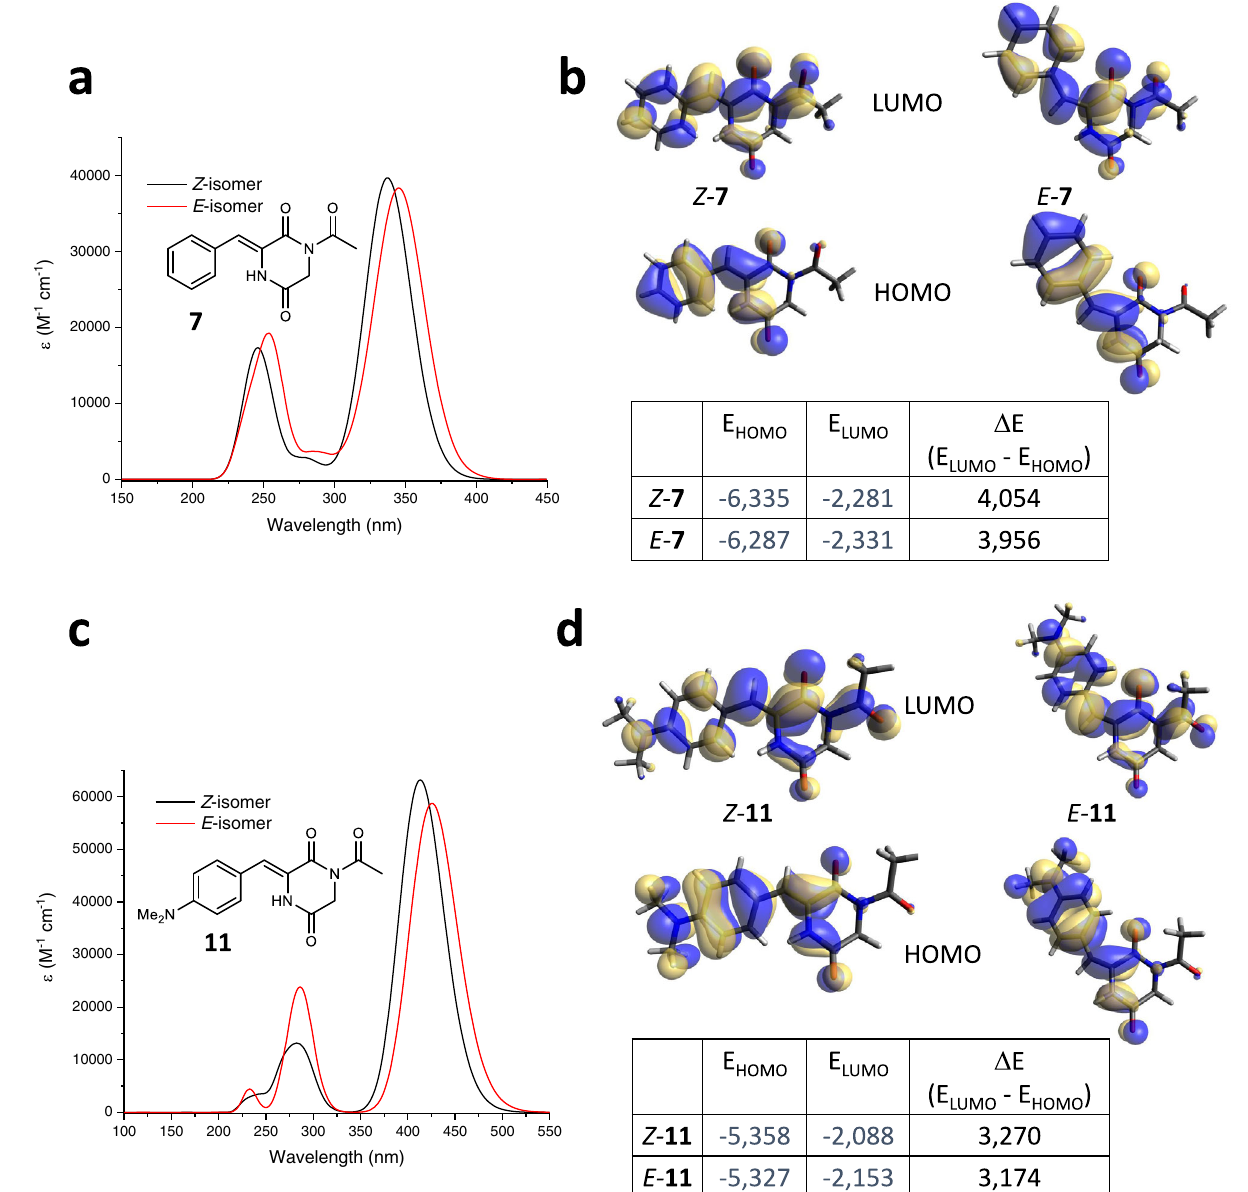
Fig. 5 | Theoretical calculations for selected HPI photoswitches. a Absorption spectra of the Z- and E- isomers of the unsubstituted HPI 7 . b selected orbital energies, as well as the electron distribution of HOMO and LUMO orbitals calcu- lated for Z- and E- isomers of 7 . c Absorption spectra of the Z- and E- isomers of the